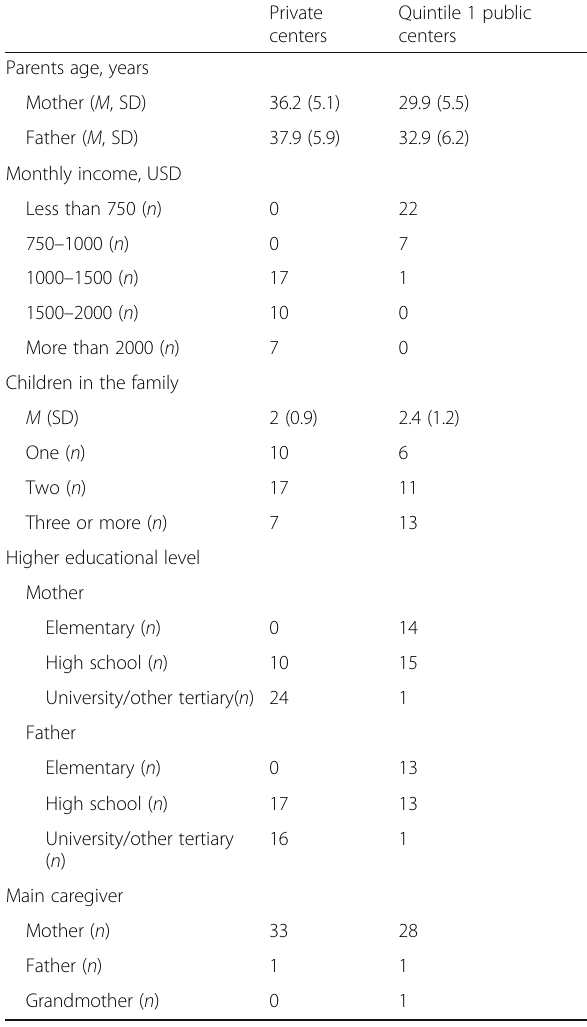
Table 1 Characteristics of the families participating in this study Private